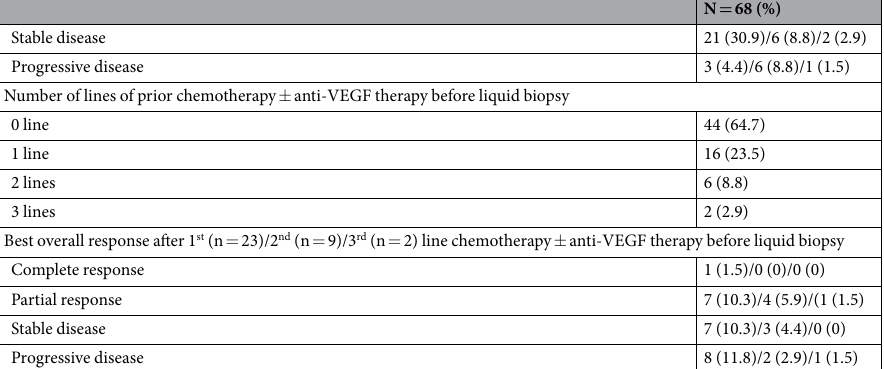
Table 1. Baseline patient characteristics. ECOG: Eastern Cooperative Oncology Group; EGFR: epidermal growth factor receptor; PD: progressive disease; PS: performance status; TKI: tyrosine-kinase inhibitors; VEGF: vascular endothelial growth